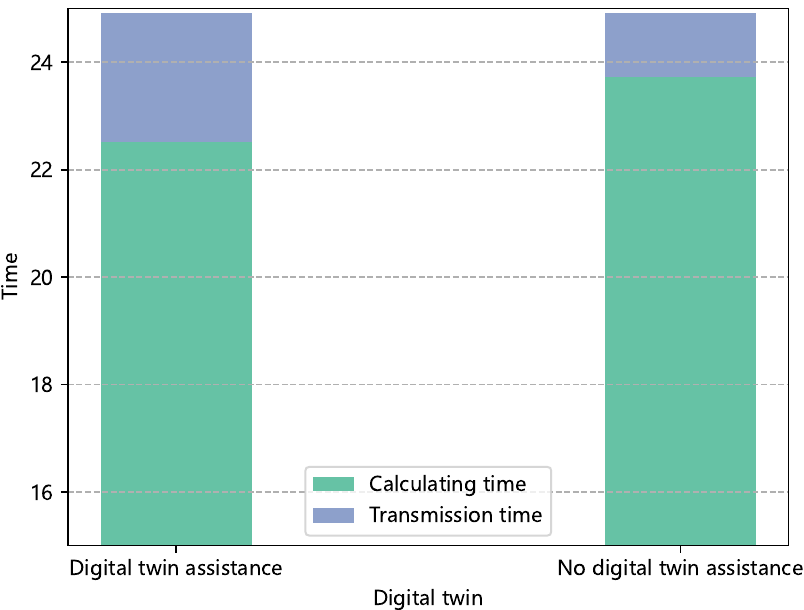
Figure 8. Comparison of the impacts of a DT on the task-computing time.